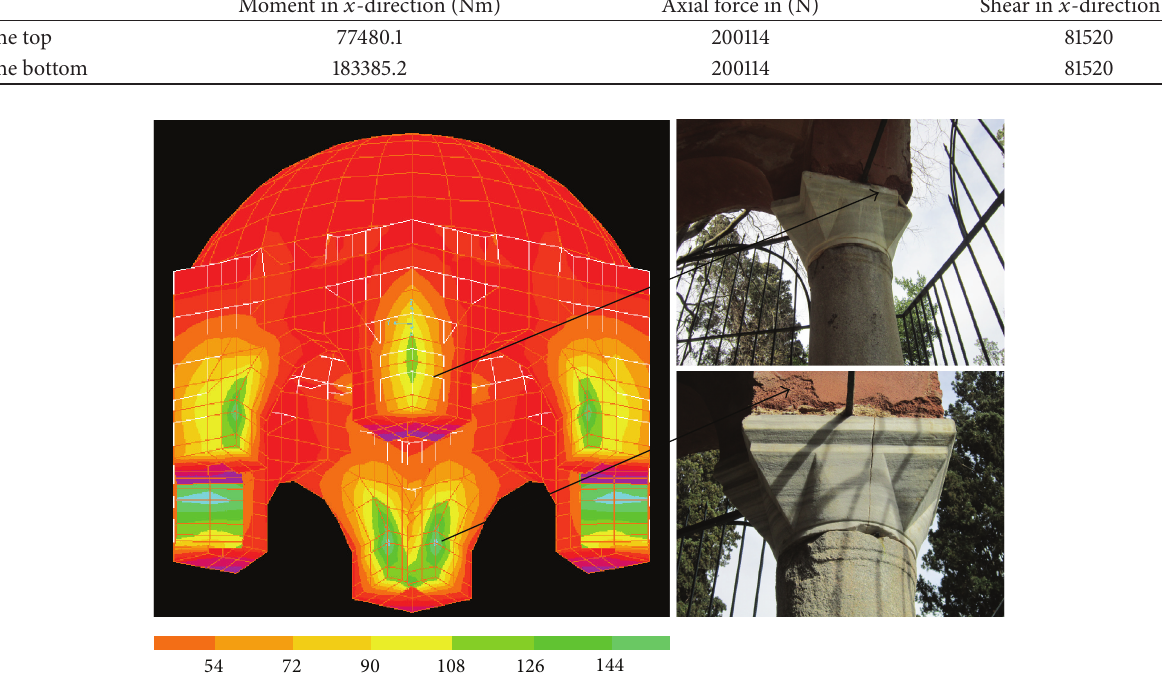
Figure 10: Maximum stresses in the roof (MPa) and related